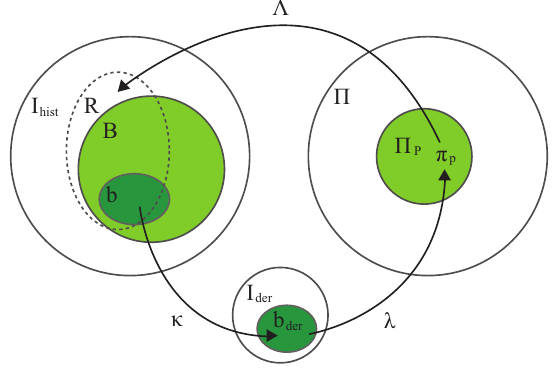
Figure 3. The LFD process with bias introduced. A derived information space I der is introduced as a space where the behavior may be represented in a task-specific way. Training data b is mapped into I der with an in- formation mapping κ . The pre-processed information in I der and var- ious ways to introduce bias in λ result in a reduced set of possible controllers P , illustrated by the light colored area in Π with Figure